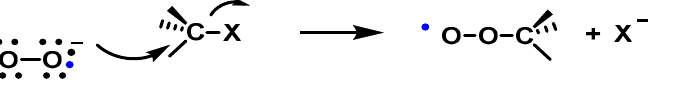
Figure 48. Formation of the C-O bond by a mechanism involving a displacement of SN2 on carbon.